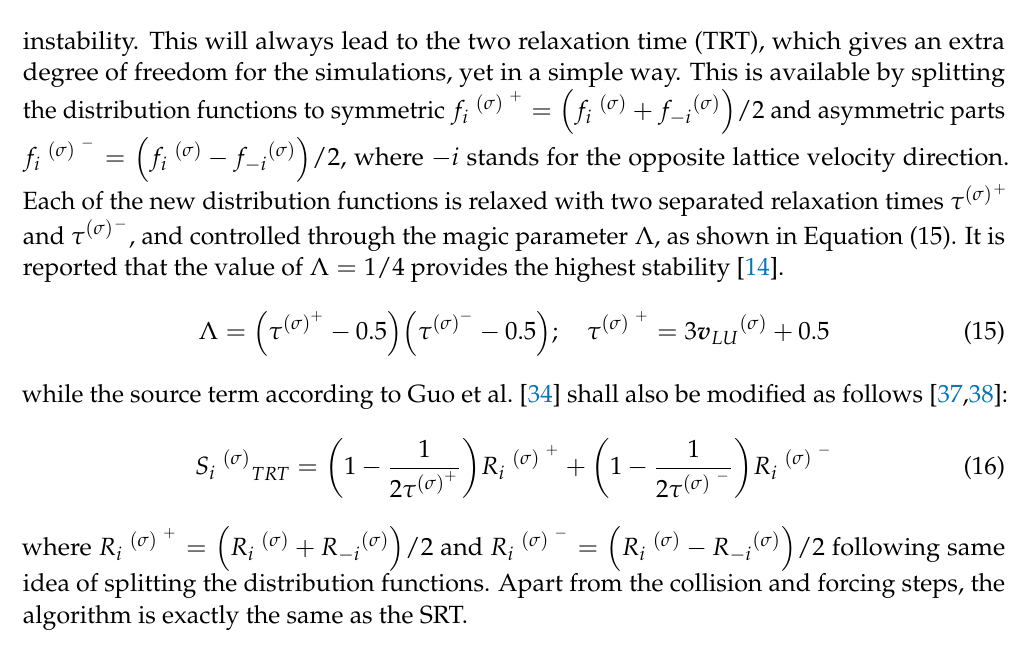
Table 2. Weighting parameter (cid:101) w